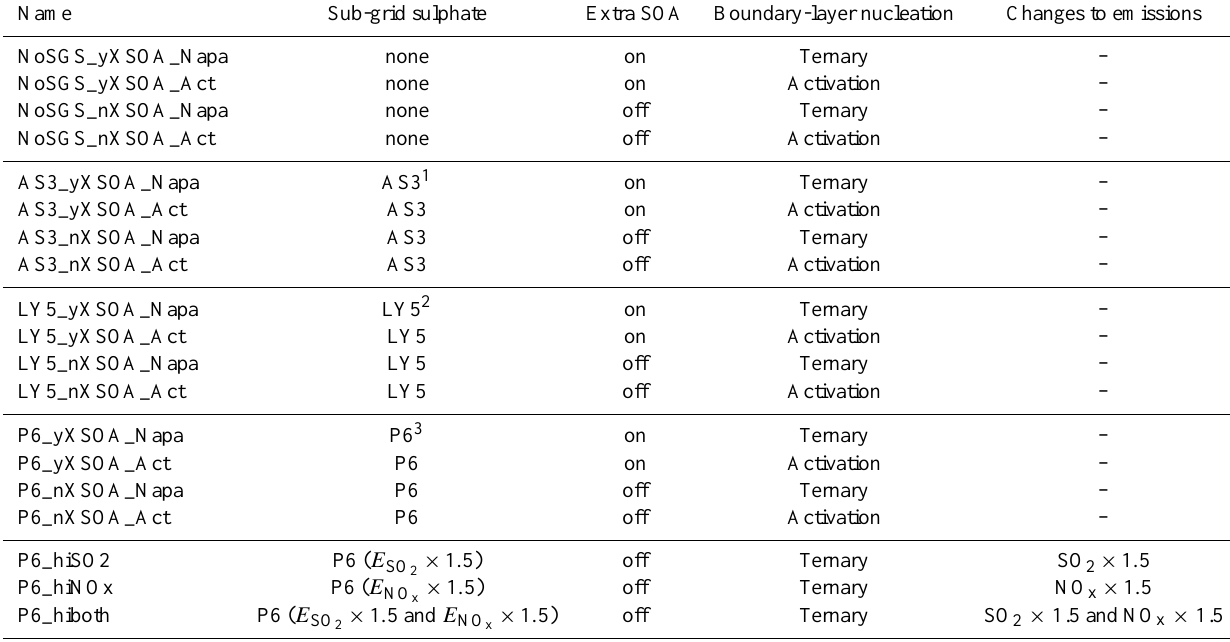
Table 1. Summary of GEOS-Chem-TOMAS simulations performed. The different sub-grid sulphate schemes and nucleation schemes are further described in Sect. 2. Extra SOA refers to emissions of 100Tgyr − 1 of SOA, co-located with emissions of CO. Name Sub-grid sulphate Extra SOA Boundary-layer